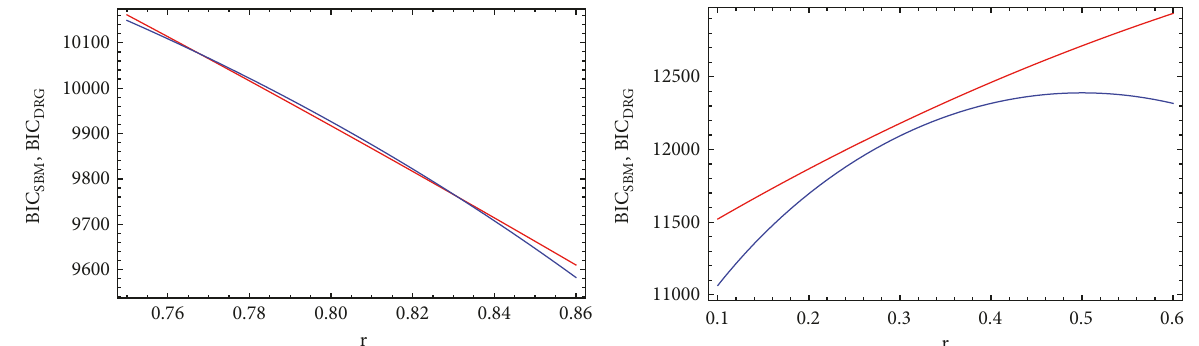
Figure 6: Left panel: comparison between the numerical values of the BIC computed for the SBM (blue trend) and the DRG (red trend), on a bimodular network where the link density of the two communities ( 𝑁 1 = 10 ; 𝑁 2 = 90 ) amounts at 𝑝 = 𝑞 = 0.8 . Notice that a region of values around 𝑟 = 0.8 exists where the SBM is penalized: only one global parameter is, in fact, enough to satisfactorily reproduce the network structure. As the link density of the off-diagonal blocks deviates from the value 𝑟 = 0.8 the network becomes more and more heterogeneous and specifying the modules is indeed rewarding. Right panel: comparison between the numerical values of the BIC computed for the SBM (blue trend) and the DRG (red trend), on a core-periphery network where the link density of the two blocks ( 𝑁 1 = 10 ; 𝑁 2 = 90 ) amounts at 𝑝 ∙ = 0.8 and 𝑝 ∘ = 0.3 . Notice that no region of values exists where the DRG is to be preferred: the network, in fact, is so heterogeneous that only one global parameter is not enough to account for its structure.